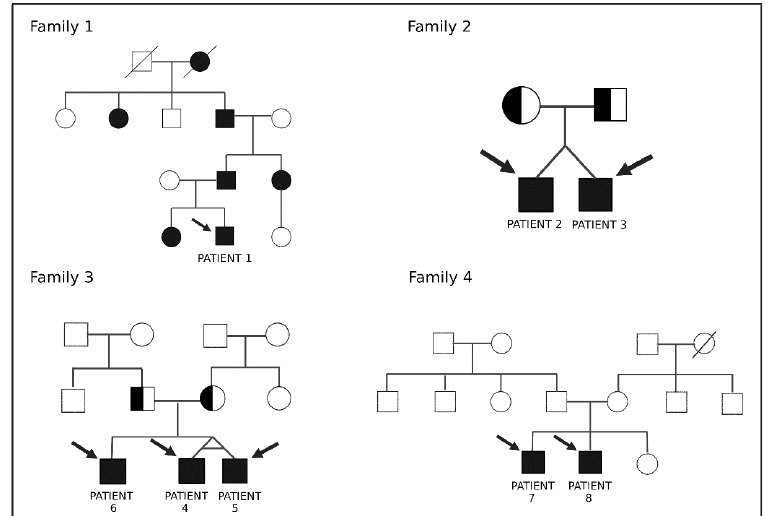
Figure 2. Pedigrees of the four selected families; circles are female and squares are male individuals, black icons are patients affected by hearing loss typical for the family, icons crossed by a line indicate deceased family members, arrows indicate patients included in the study. Table 2. Results of additional whole exome sequencing-based panel testing.